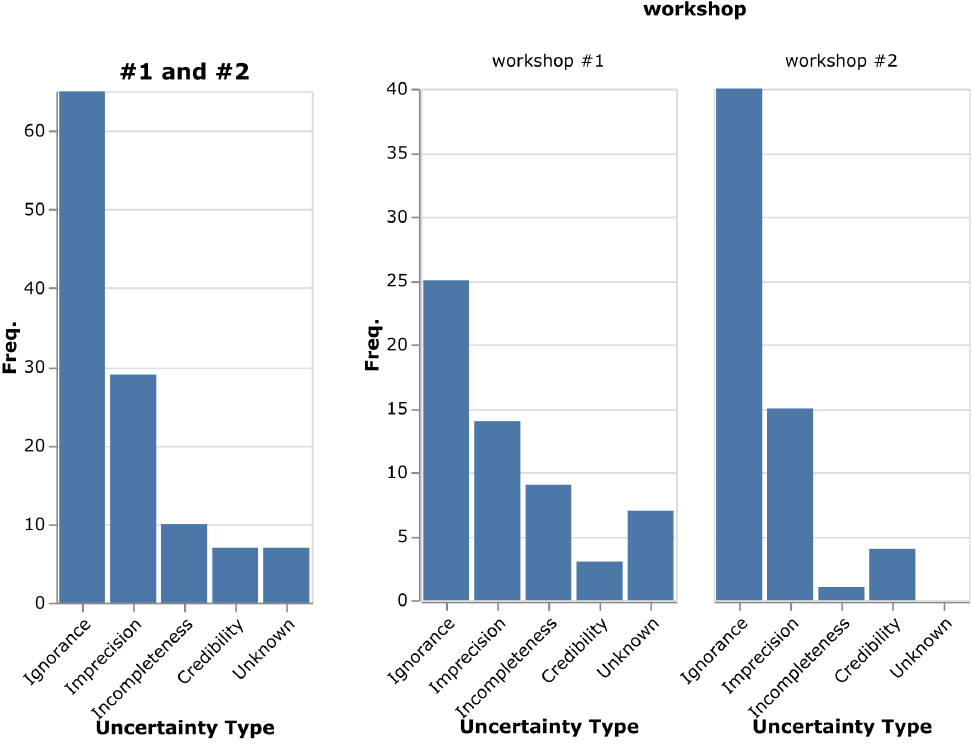
Figure 6. ( Left ) Distribution of uncertainty annotations by category. ( Right ) Breakdown by workshop. By a large margin, the “ignorance” category was the most used by participants in our study, followed by “imprecision”. In addition, participants made a total of 7 annotations that they could not link to any of the categories in the